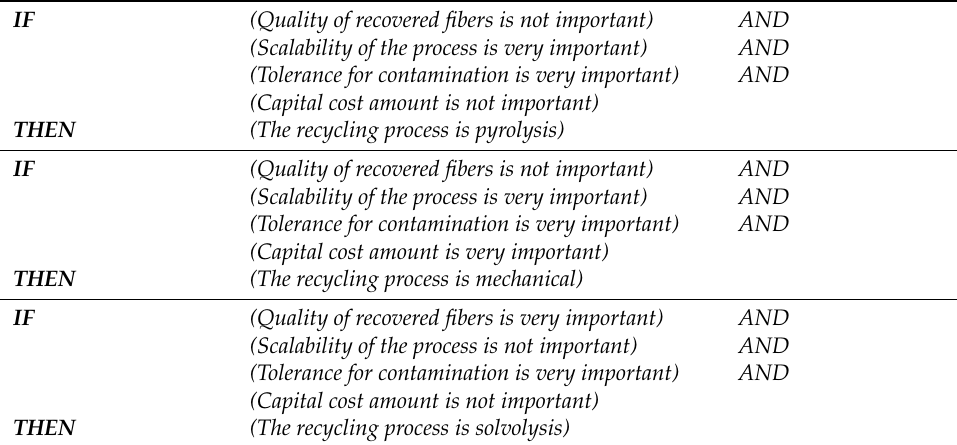
Figure 2. Overall structure of the developed system. Table 5. The algorithm for the selection of the recycling